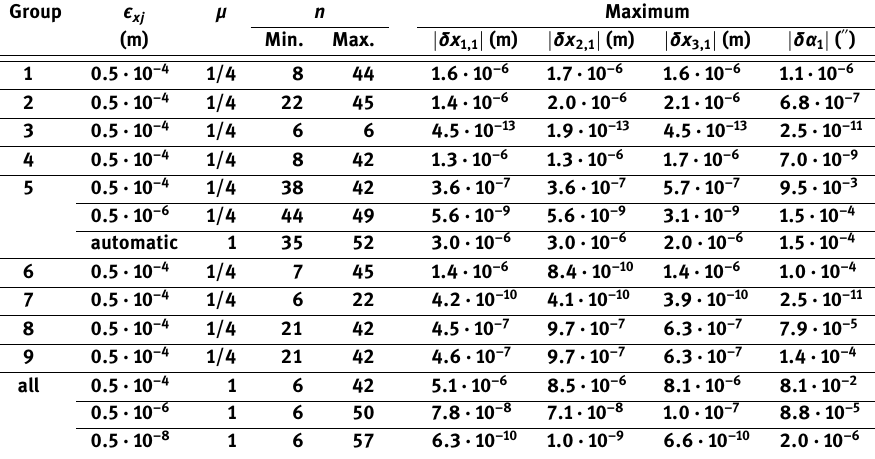
Table 4. Maximum coordinate errors δx , j = 1, 2, 3, and errors δα 1 of the azimuth of the solutions of the direct problem with truncation j ,1 criterium (32) and applied error limits ϵ and factors µ ; minimum and maximum Taylor series order n ; automatic: procedure of Section 4.3 xj with ϵ = 0.5 · 10 −3 ′′ α